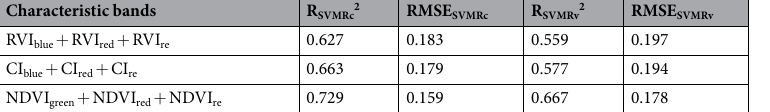
Characteristic bands R SVMRc2 RMSE SVMRc R SVMRv2 RMSE SVMRv RVI blue + RVI red + RVI re 0.627 0.183 0.559 0.197 CI blue + CI red + CI re 0.663 0.179 0.577 0.194 NDVI green + NDVI red + NDVI re 0.729 Table 8. The SVMR models for estimation of chlorophyll content based on vegetation indices. Note: R SVMRc2 was the determination coefficient of the SVMR model; R SVMRv2 was the verification determination coefficient of the SVMR model; RMSE SVMRc was the root mean square error of the SVMR model; RMSE SVMRv was the verification root mean square error of the SVMR